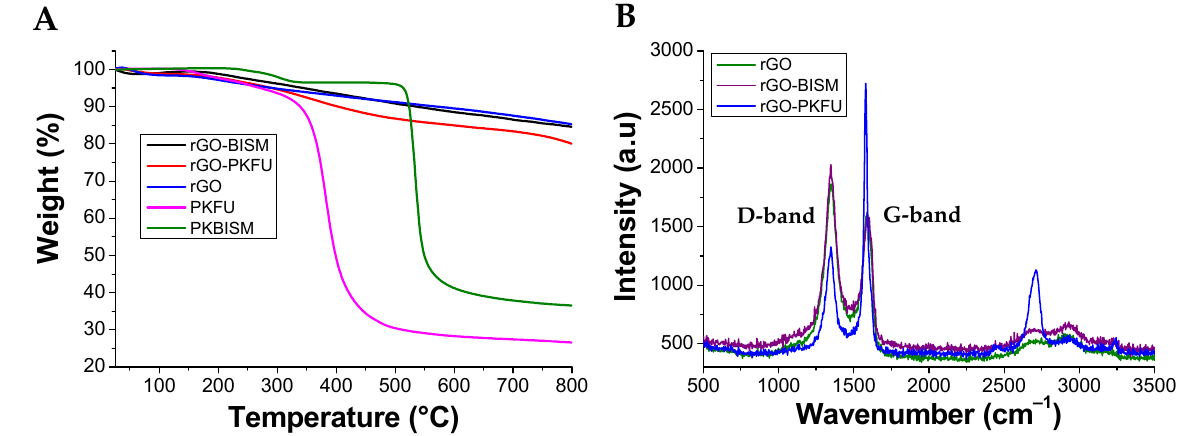
Figure 9. TGA ( A ) and Raman analysis ( B ) of rGO mixed with BISM and PKFU.